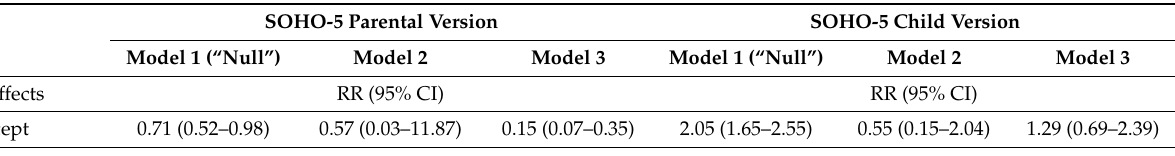
Table 3. Multilevel Poisson regression analysis of the associations between the SOHO-5 (parental and child versions) scores and individual and contextual